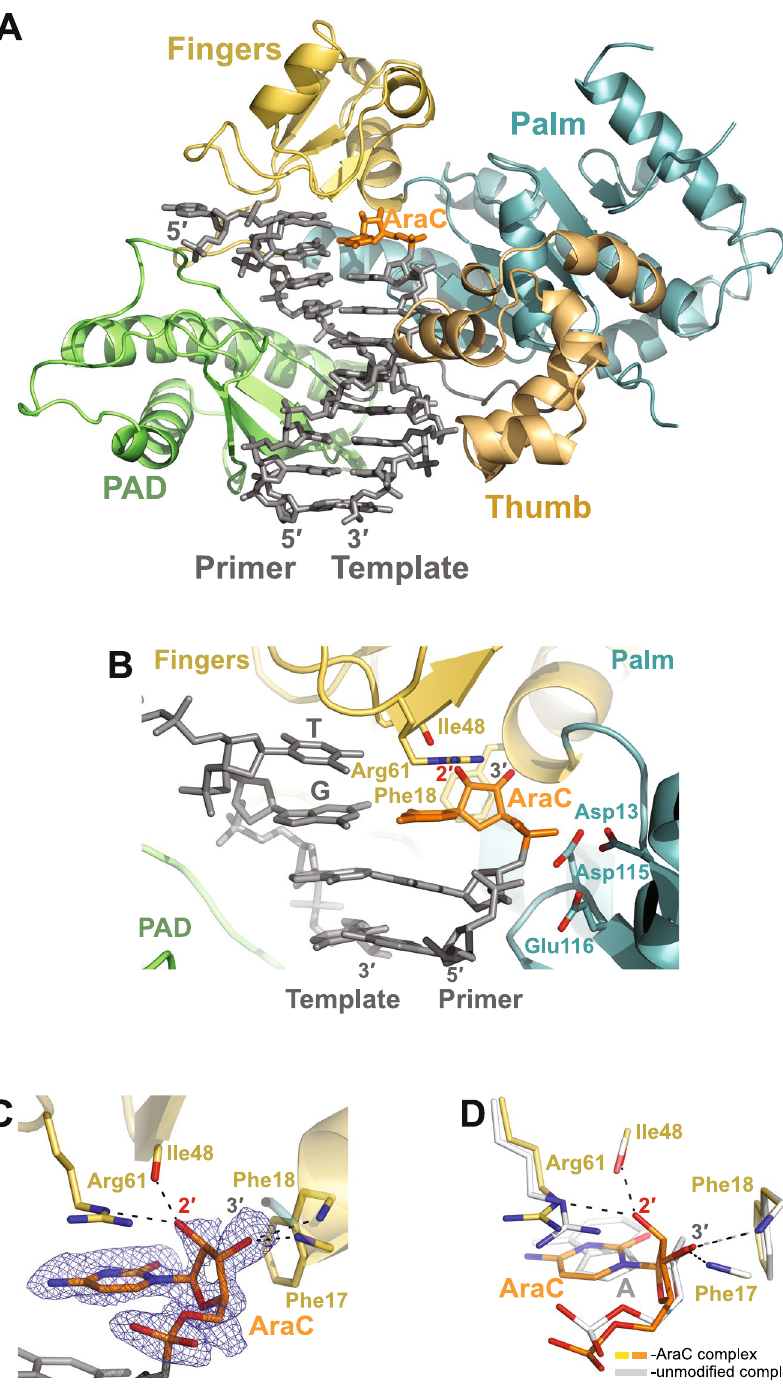
Figure 3. The Pol η AraC post-insertion binary complex. ( A ) Overall structure of the complex; the palm, fingers, thumb and PAD domains are shown in cartoon representation in cyan, yellow, light orange, and green, respectively. The DNA template–primer duplex is shown in gray sticks with the 3 ′ -terminal primer AraC residue in orange. ( B ) A close-up view of the AraC in the active site of Pol η . Asp13, Asp115, and Glu116 are the catalytic residues. ( C ) A simulated annealing Fo − Fc omit map (contoured at 3.0 σ -level at 1.83 Å resolution and colored in blue) showing the clear electron density for the entire AraC residue. The sugar moiety of the AraC is stacked against the steric gate residue Phe18 and its 2 ′ -OH group points away from it. ( D ) Superposition of the AraC and the unmodified (PDB ID: 4J9P) 36 post-insertion binary complexes. The unmodified complex is in white and has an unmodified A residue at the 3 ′ -end of the primer strand; the structures are superimposed by the palm and fingers domains of the polymerase. Both, the AraC and the unmodified A sugar moieties have C3 ′ - endo